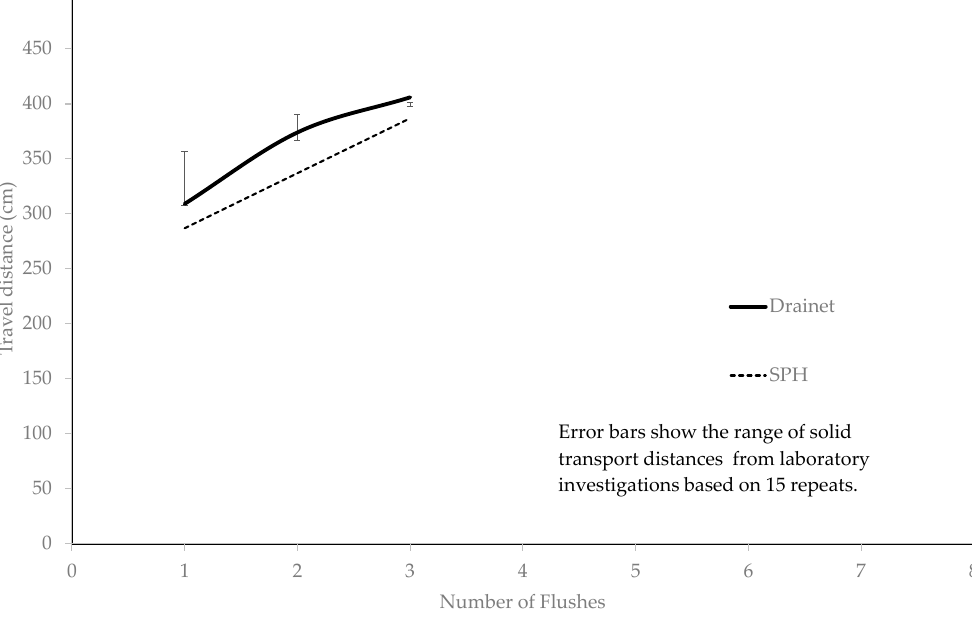
Figure 7. Comparison between laboratory results, DRAINET results, and SPH results for a simulated solid of 80 mm length with a diameter of 36 mm, a specific gravity (SG) of 0.85, a mass of 69 g, and a density of 850 kgm − 3 .